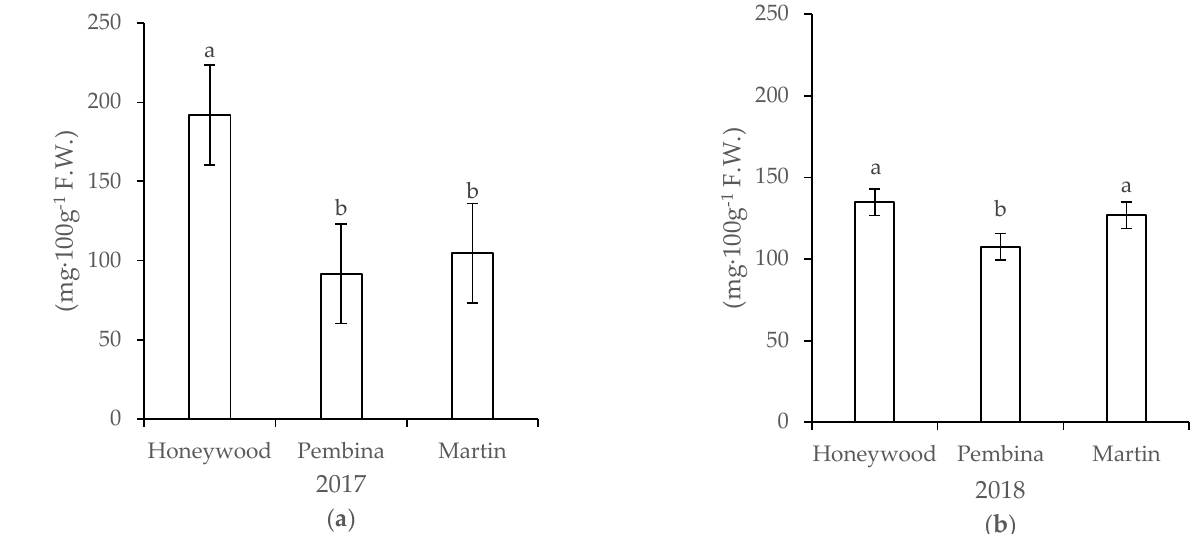
Figure 7. Total polyphenol content in the fruits of the studied cultivars in ( a ) 2017 and ( b ) 2018. Values with different letters are significantly different within a year.